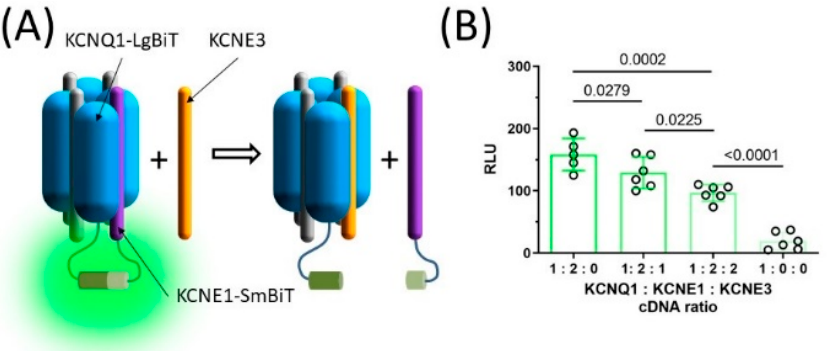
Figure 5. KCNE3 shifts subunit stoichiometry of the I Ks channel complex. The large (LgBiT) and the small (SmBiT) fragment of the split NanoLuc luciferase were fused the C-termini of KCNQ1 and KCNE1, resulting in KCNQ1-LgBiT and KCNE1-SmBiT. The LgBiT and SmBiT fragments complement each other and produce bioluminescence when in the proximity to each other ( A ). Average ±95% CI relative bioluminescence values (RLU) observed in the presence of varying KCNQ1-LgBiT, KCNE1-SmBiT and KCNE3 ratio ( B ). Group means were statistically compared by one-way ANOVA followed by Holm–Sidak’s post-hoc